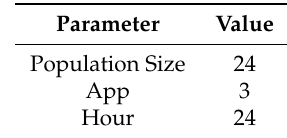
Table 3. TLBO parameters and